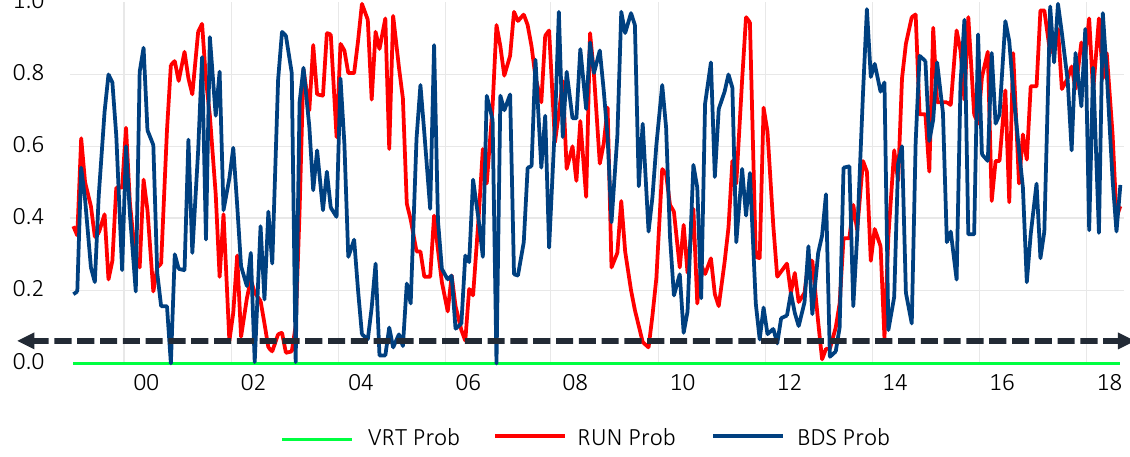
Figure 2. ZARCNY VR, runs and BDS p-values (2-year window, rolled by 1-month)